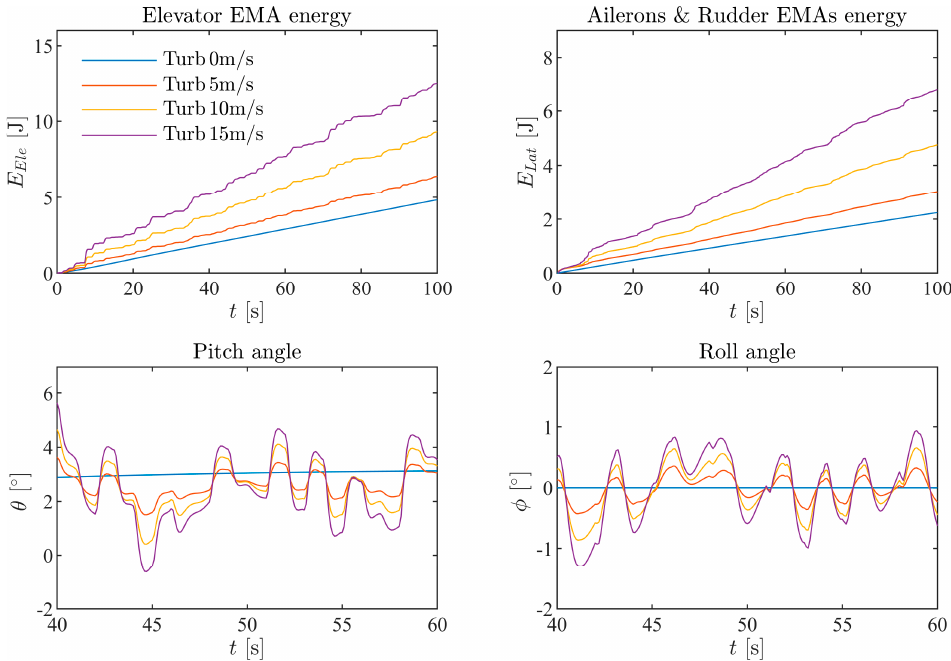
Figure 16. Longitudinal, lateral-directional EMAs energy consumption, and attitude response for different turbulence intensities (5 m/s, 10 m/s, 15 m/s).